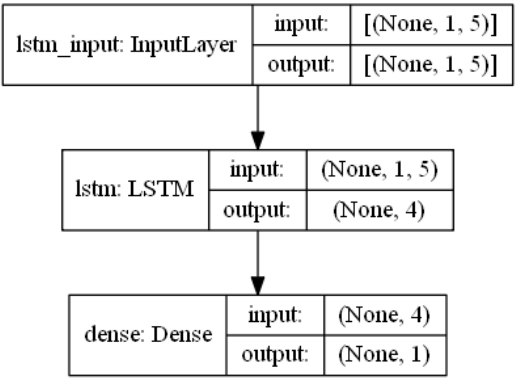
Figure 4. LSTM model